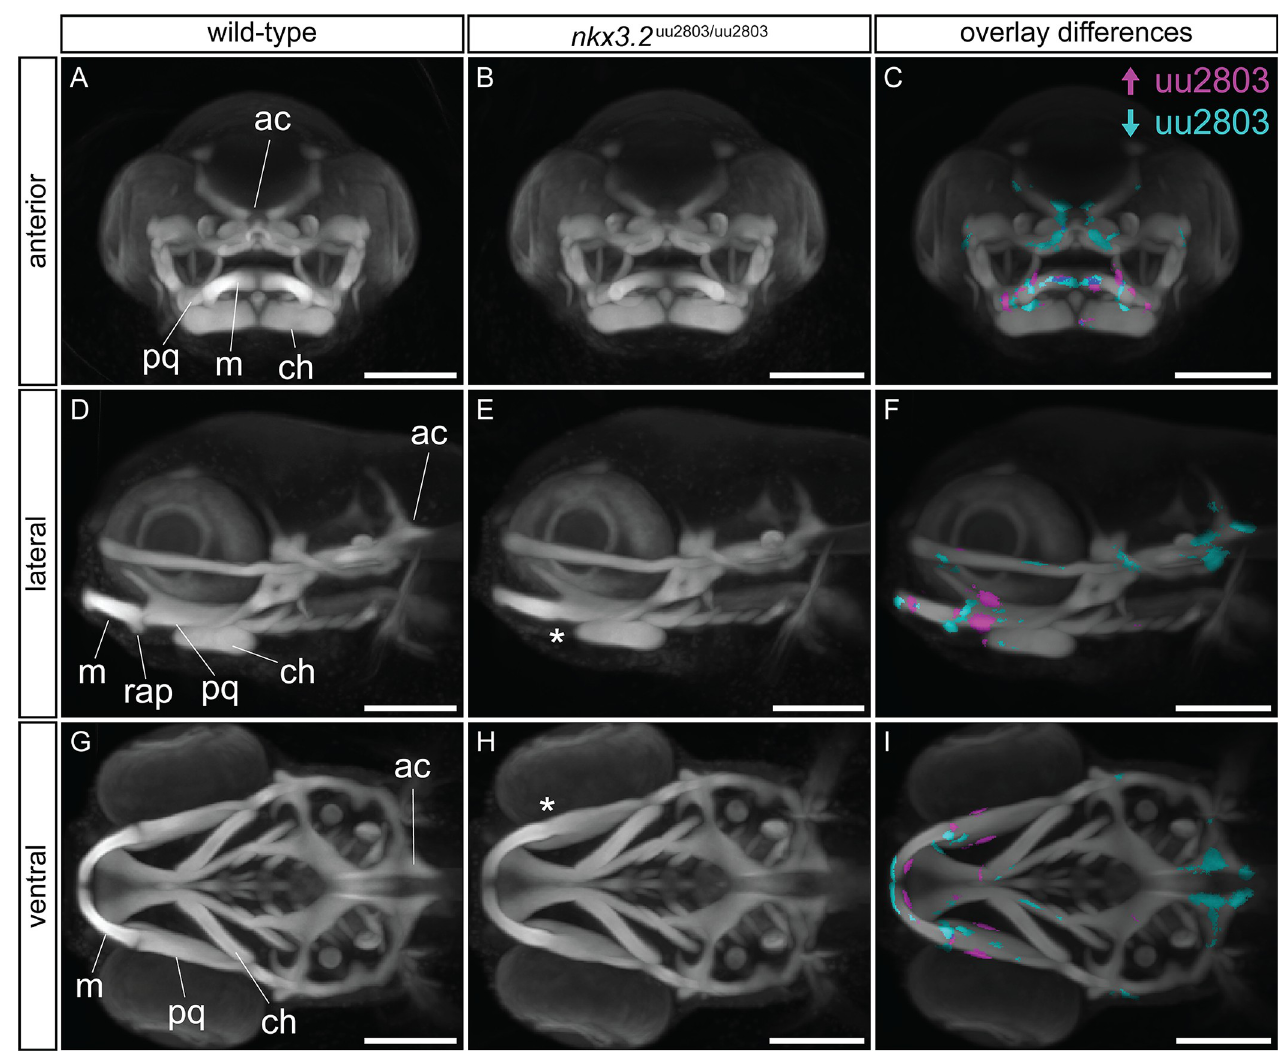
Fig 4. Optical projection tomography of cartilage-stained wild-type and nkx3 . 2 uu2803/uu2803 larvae reveals subtle phenotypic changes. ( A, D, G ) Maximum projection of 5 dpf wild-type group (n = 10). ( B, E, H ) Maximum projection of 5 dpf nkx3 . 2 mutant (n = 11) group. ( C, F, I ) Maximum projection of both groups with coloured voxels representing voxels with statistically significant (p < 2.5x10 -4 ) differences in intensity. Magenta shows voxels with higher intensity and cyan shows voxels with lower intensity in nkx3 . 2 mutant group. Asterisk marks the fusion site. ch–ceratohyal, m–Meckel’s cartilage, ac–auditory capsule, pq–palatoquadrate, rap–retroarticular process. Scale bars: 150 μ